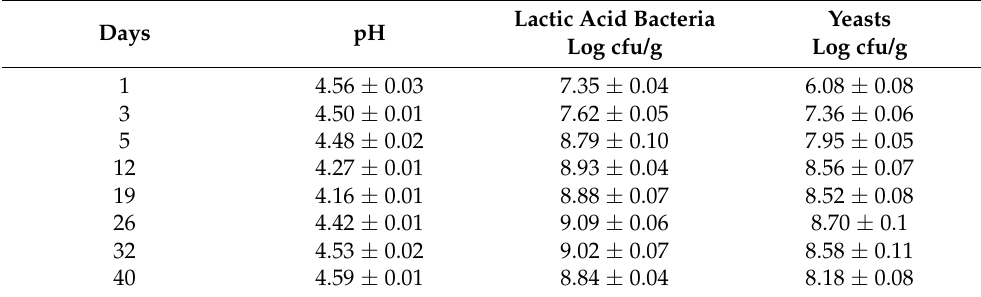
Table 1. Effect of silage time on growth of pH, lactic acid, and yeast population (log cfu/g) in corn silage, supplemented with pomegranate and avocado peel, used as feed for poultry growth.